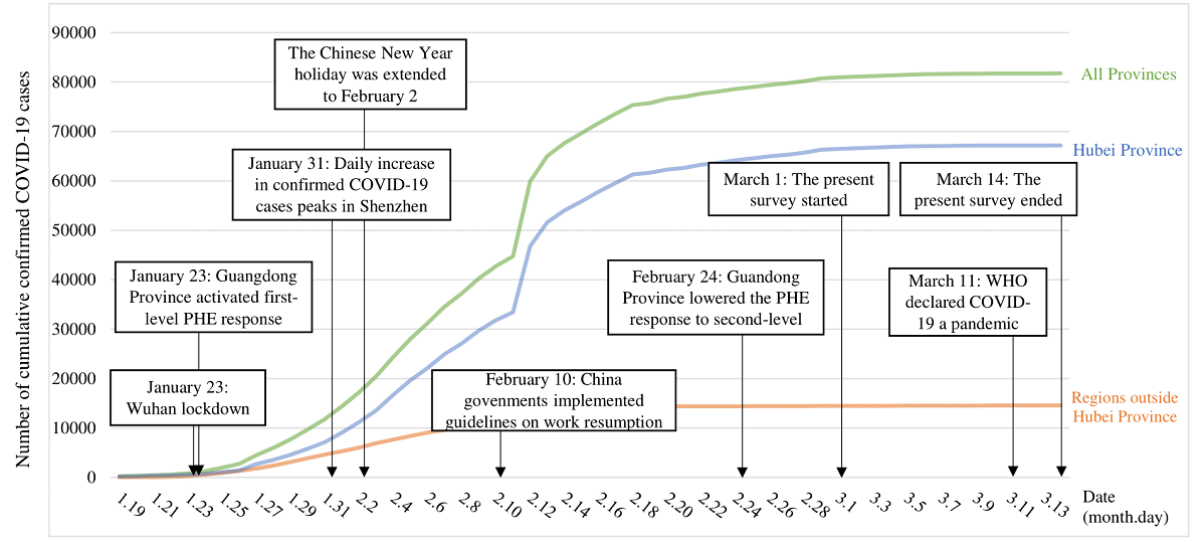
Figure 1. Background of the present survey, including the trend of cumulative confirmed COVID-19 cases in mainland China and critical responses to COVID-19 in Shenzhen, a city in Guangdong Province. PHE: public health emergency; WHO: World Health